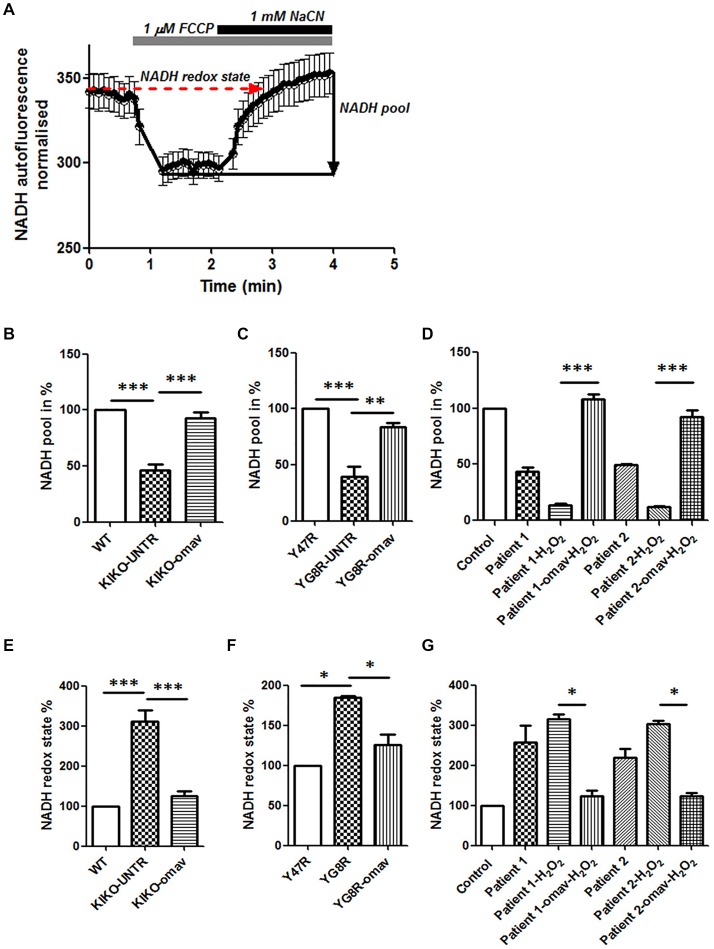
Omaveloxolone (Omav) prevents Complex I inhibition in friedreich’s ataxia (FRDA) fibroblasts and neurons. (A) Representative trace of nicotinamide adenine dinucleotide (NADH) autofluorescence where the basal level refers to the NADH redox state and the response to NaCN subtracting the response to carbonyl cyanide-4-(trifluoromethoxy)phenylhydrazone (FCCP) represents the NADH pool. (B–D) The histograms represent the calculation total NADH pool in KIKO, YG8R cerebellar granule neurons (CGNs) and Patients compared to their controls and without/with omav (**p < 0.005; ***p < 0.0005). (E–G) The histograms represent the calculation total NADH redox state in KIKO, YG8R CGNs and Patients compared to their controls and without/with omav (*p < 0.05; ***p < 0.0005).